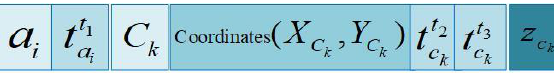
Figure 6. Localization message block.